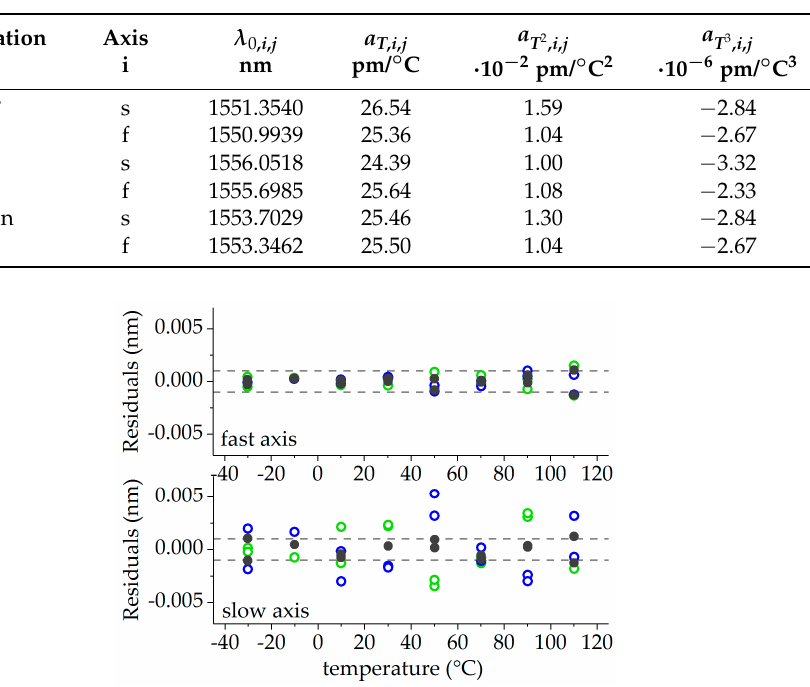
Figure 8. Temperature calibration of the surface-attached PM tandem: FBG in the 0 ◦ -orientation in green, FBG in the 90 ◦ -orientation in blue, and mean values in grey. Table 2. Fitting parameters of the temperature calibration of the PM tandem.